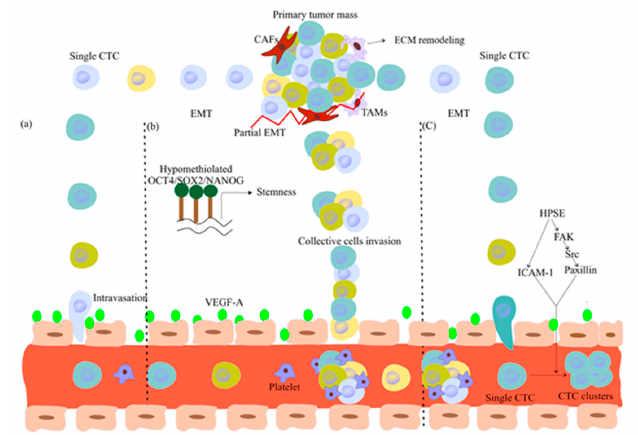
Figure 1. Models of CTC intravasation and cluster formation. ( a ) EMT allows single CTCs to detach from the primary tumor lesion; then, VEGF expression increases endothelial permeability and promotes CTC intravasation and dissemination to distant organs. ( b ) TAMs contribute to metastasis formation by ECM remodeling, and CAFs physically pull away cancer cells from the primary tumor. Partial EMT and stemness features due to OCT4, NANOG, SOX2 upregulation in cancer cells within clusters enhance cell–cell junction formation and facilitate collective invasion, intravasation, dissemination, and metastasis initiation. ( c ) Clusters may be formed by intravascular aggregation of single CTCs that overexpress heparanase (HPSE) via HPSE-mediated induction of cell–cell adhesion molecules, such as intercellular adhesion molecule-1 (ICAM-1) and the focal adhesion kinase (FAK)- Src-paxillin pathway. Abbreviations: CTC, circulating tumor cell; EMT, epithelial-to-mesenchymal transition; VEGF, vascular endothelial growth factor; TAM, tumor-associated macrophages; ECM, extra cellular matrix; CAF, cancer-associated fibroblasts.